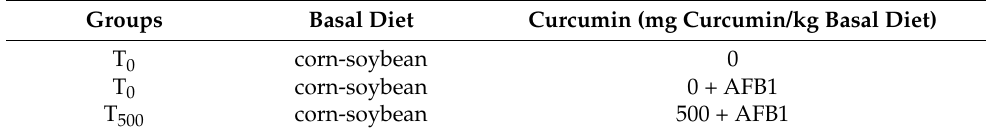
Table 1. Experiment design. Groups Basal Diet Curcumin (mg Curcumin/kg Basal Diet) T 0 corn-soybean 0 T 0 corn-soybean 0 + AFB1